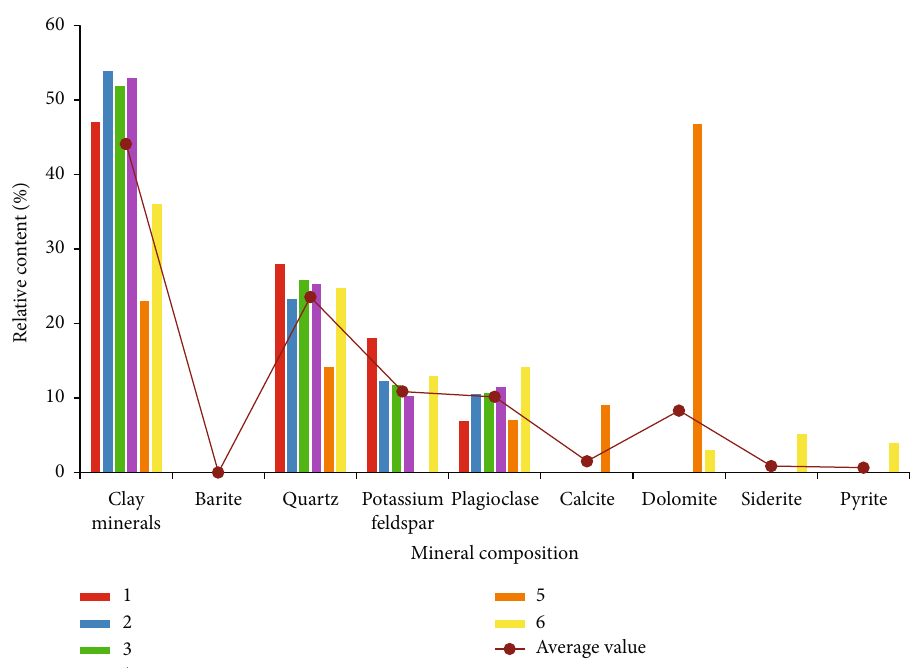
Figure 2: Experimental results of composition of clay minerals.